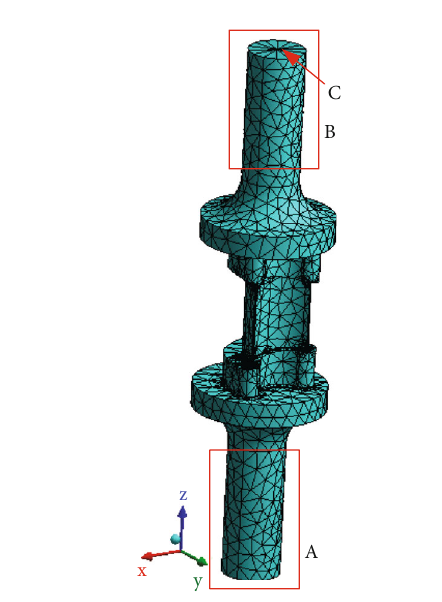
Figure 17: Grids of the blade